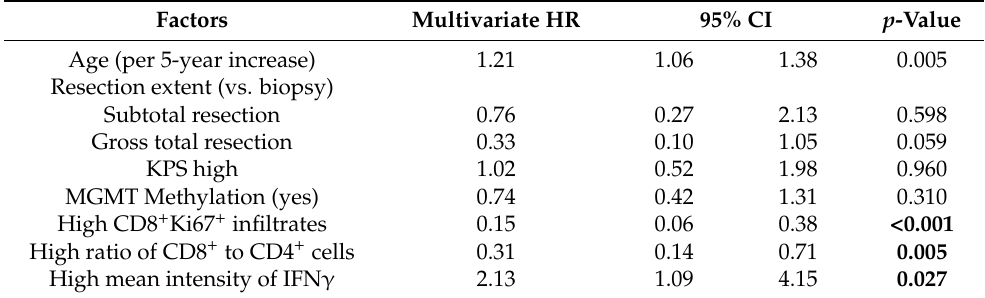
Table 3. Multivariate analysis of evaluated clinical and immunological factors and overall